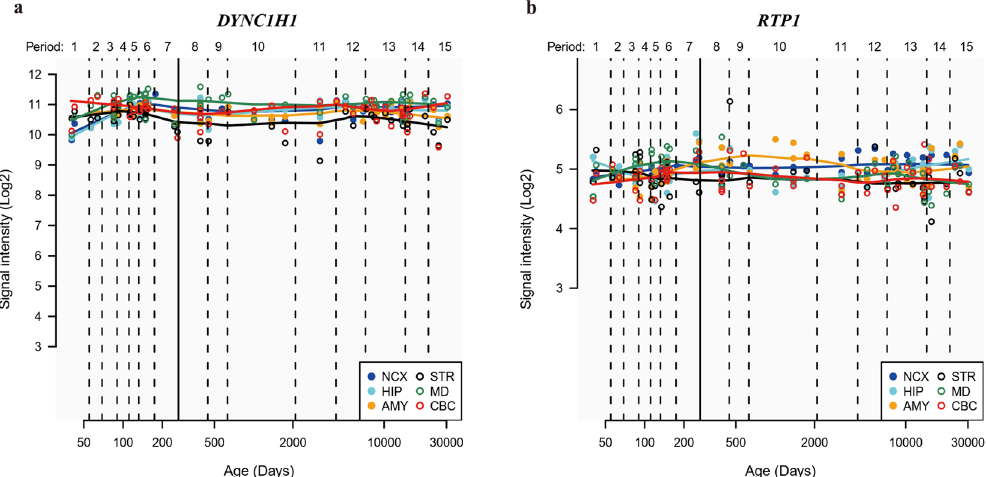
Figure 2. Expression analysis of DYNC1H1 and RTP1 in six human brain regions. Expression profiles are shown for DYNC1H1 ( a ) and RTP1 ( b ). The expression levels of DYNC1H1 and RTP1 are shown for the developmental stages from the embryonic development stage at 50 days to late adulthood (e.g., 30,000 days). A solid line between periods 7 and 8 separates prenatal periods from postnatal periods. CBC, cerebellar cortex; MD, mediodorsal nucleus of the thalamus; STR, striatum; AMY, amygdala; HIP, hippocampus; NCX, neocortex.